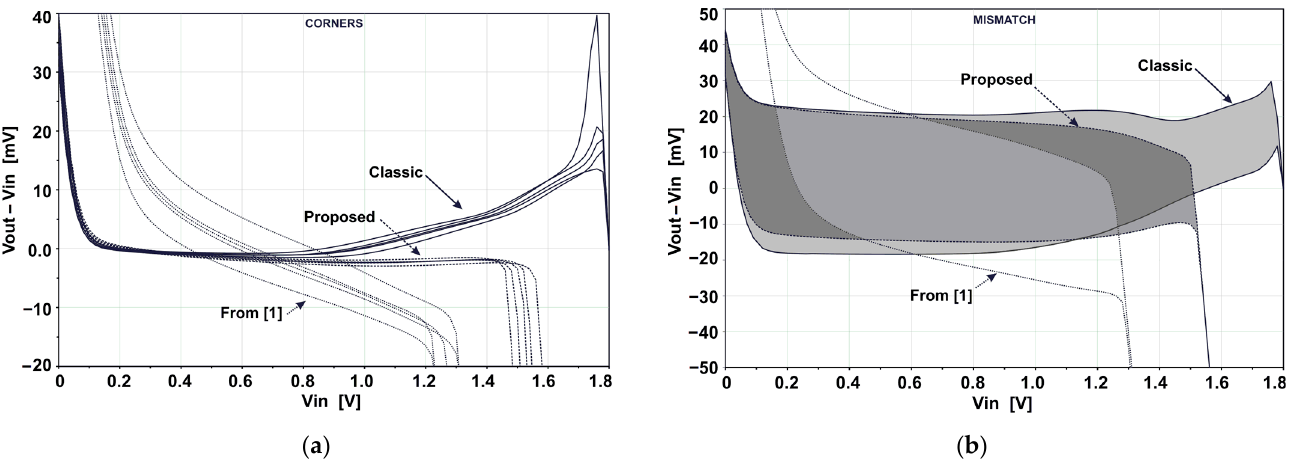
Figure 6. Simulated offset induced by: ( a ) process corners (nominal and four corners: wz, wo, ws, wp); ( b ) mismatch (500 monte carlo runs).